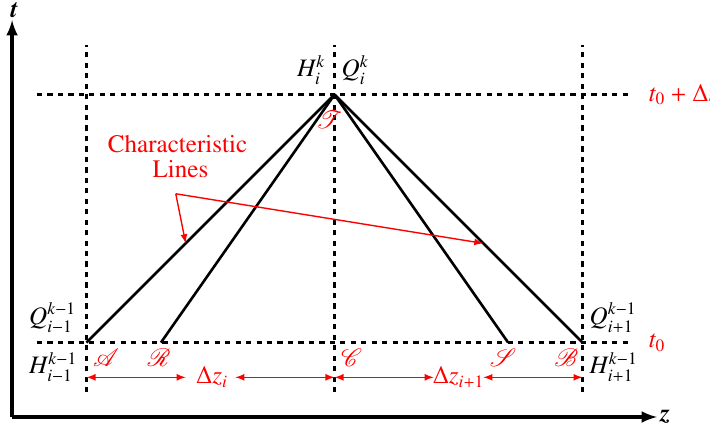
Figure 2. MOC-based discretization